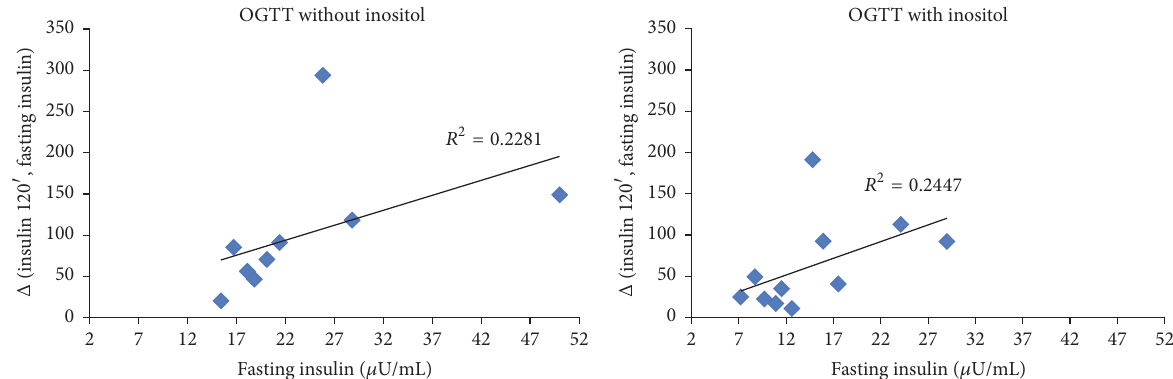
Figure 2: Correlation between basal insulin level and insulin increase from fasting to 120 minutes after OGTT without or with inositol in subjects with a basal insulin level ≥ 15 𝜇 U/mL. (a) 𝑝 = 0.0009 . (b) 𝑝 = 0.0767 .